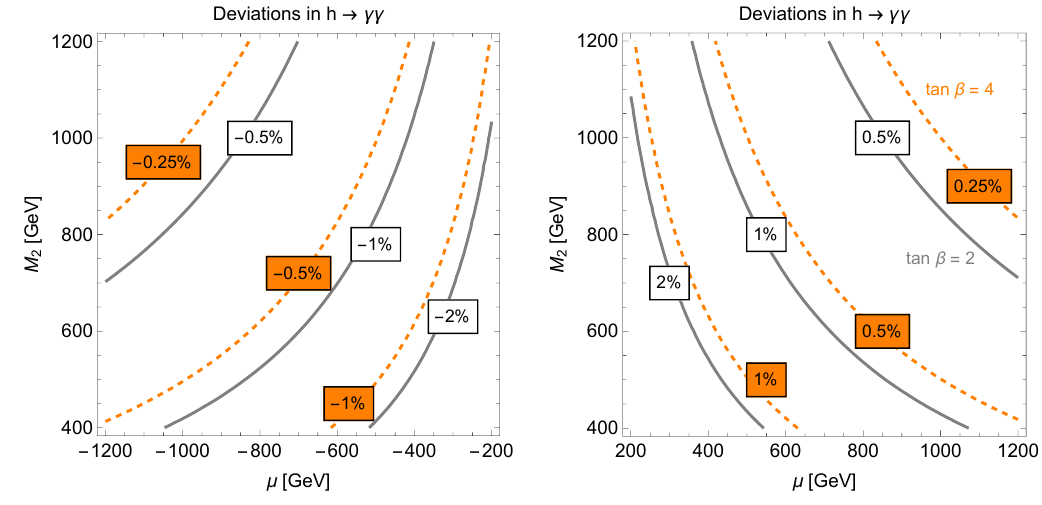
Figure 5 . E(cid:11)ect of chargino loops on the h ! (cid:13)(cid:13) branching fractions, which can lead to percent- level deviations from the Standard Model expectation. Left: (cid:22) < 0; right: (cid:22) > 0. Solid curves: tan (cid:12) = 2. Dashed orange curves: tan (cid:12) =